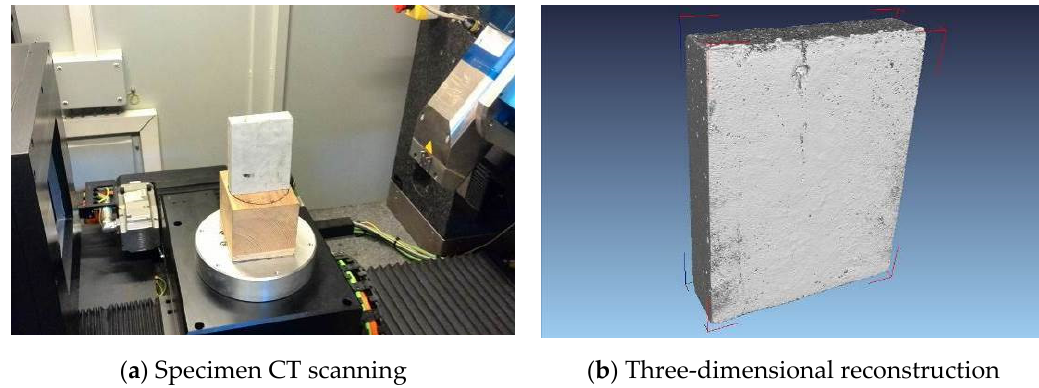
Figure 15. Three-dimensional CT scanning and reconstruction of ECC cracked specimen.